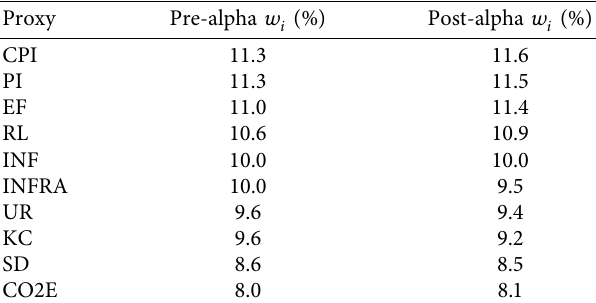
Table 4: Comparison of the expert weights between pre- and post- alpha value